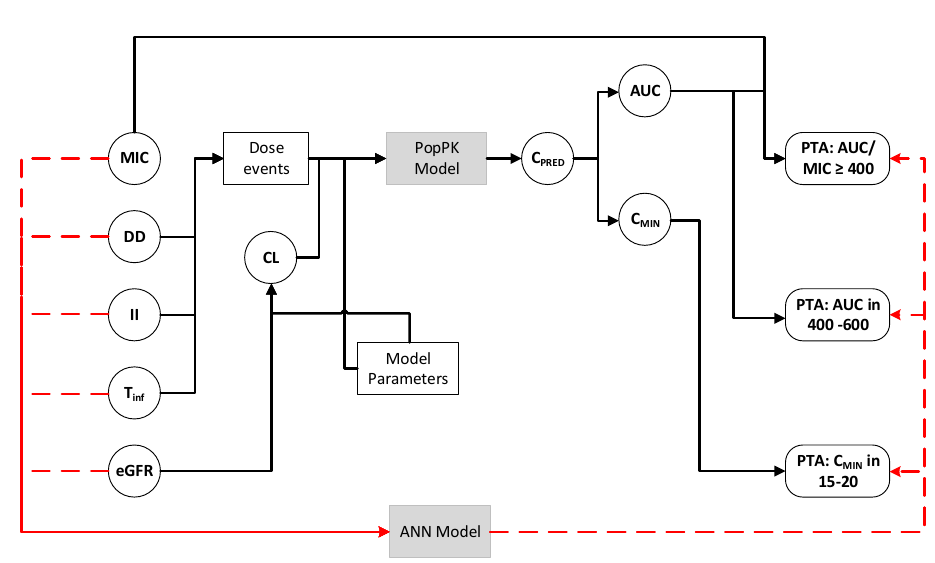
Figure 1. Schematic representation of the applied model